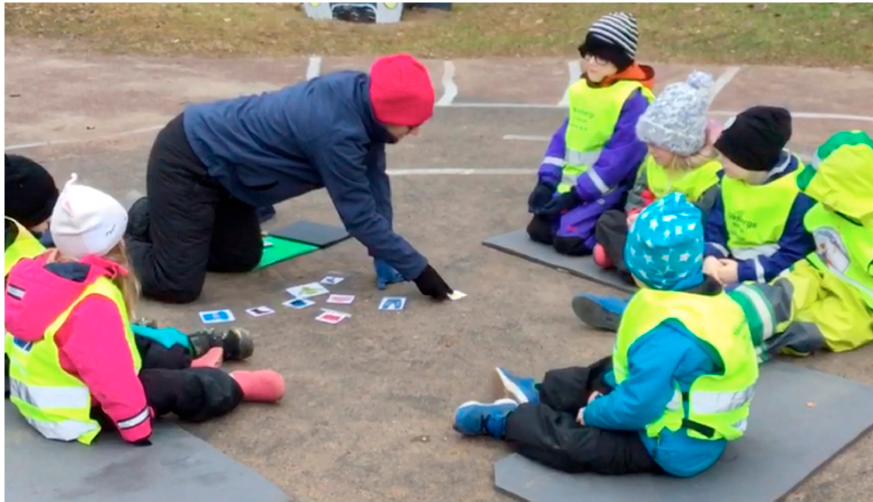
Figure 1. An analogue programming session using paper cards.